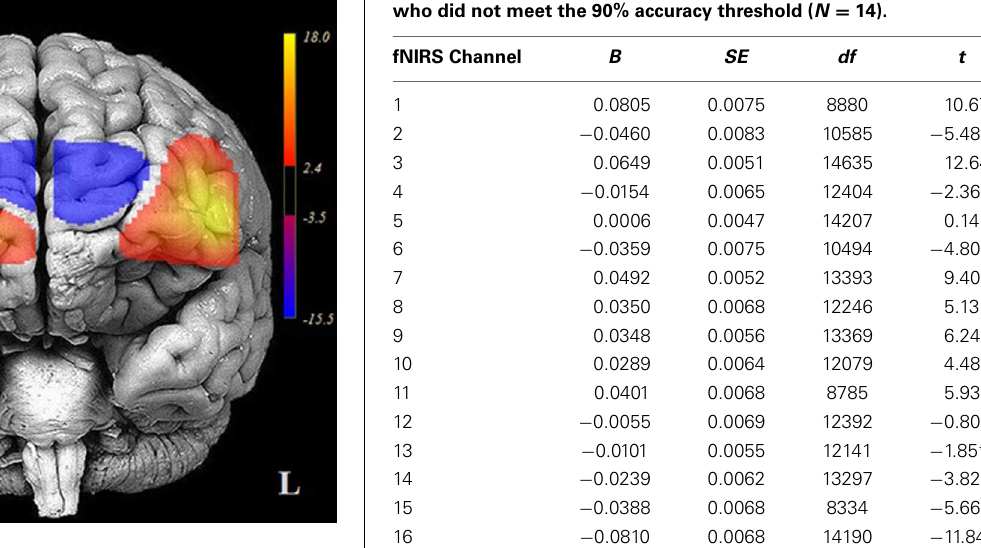
FIGURE 5 | Areas of significant activation and deactivation associated with solving two- and three-move problems on the Scarborough adaptation of the Tower of London (S-TOL) task for participants matched for high accuracy ( N = 24). Areas of significant activation are denoted in red, and areas showing significant deactivation are in blue. Data represent t -scores for the contrast of multiple-move and zero-move conditions ( p < 0 . 05, False-Discovery Rate-corrected).